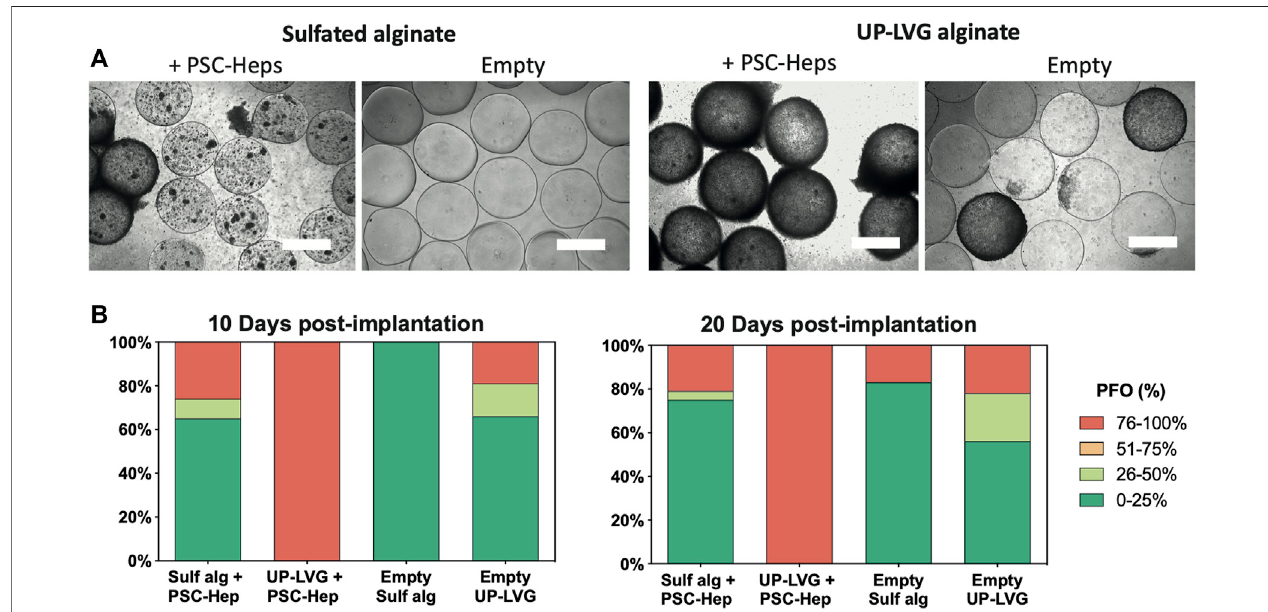
FIGURE 4 | Ex vivo assessment of pericapsular fi brotic outgrowth on the non-modi fi ed and sulfated alginate microbeads. (A) Bright fi eld microscopy images of alginatemicrobeadsretrievedfrommice10 daysafterintraperitonealimplantation.hPSC-HepsspheroidsencapsulatedinsulfatedalginateshowalowerdegreeofPFO comparedto thespheroids encapsulated in non-modi fi ed alginate. Similarly, sulfated alginate empty microbeads show alower degree ofPFO than empty non-modi fi ed alginate. Scalebars: 500 μ m (B) Stack bars showing the averagedegree ofPFO for thealginate microbeadsretrieved fromthe peritoneal cavity ofmice at 10 days and 20 days post-implantation timepoints. Upon extraction on day 10 (left), hPSC-Heps encapsulated in sulfated alginate and empty sulfated alginate microbeads showed overall decreased PFO compared to hPSC-Hep-encapsulated and empty UP-LVG alginate microbeads ( n > (cid:1) 26 beads retrieved per group); similar but more pronounced difference was observed on day 20 (right) ( n > (cid:1) 9 beads retrieved per